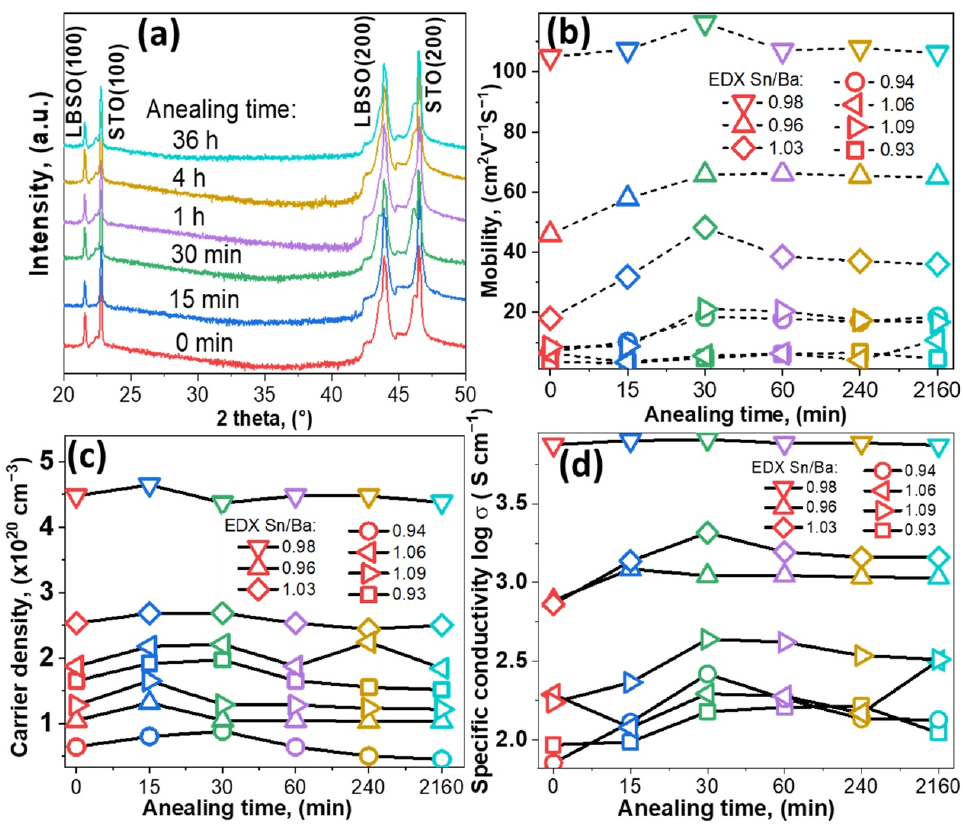
Figure 1. ( a ) XRD pattern of single ‐ phase LBSO sample with Sn/Ba ratio of 0.98 annealed at 900 °C for different durations, ICDD PDF #00 ‐ 042 ‐ 1468. ( b – d ) Electron mobility, carrier density, and specific conductivity of different LBSO samples with their respective Sn/Ba ratios (0.93, 0.94, 0.96, 0.98, 1.03, 1.06, and 1.09) annealed for different durations.